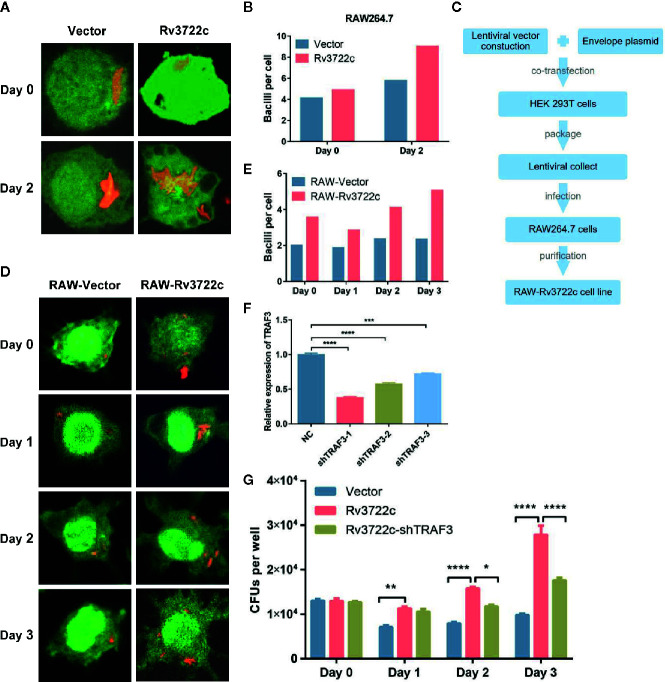
Knock-down of TRAF3 attenuates the effect of Rv3722c on M.tb proliferation. (A) pcDNA3.1-V5-Rv3722c or pcDNA3.1-V5 vector control and pAAV-eGFP were transiently co-transfected into RAW264.7 cells. Cells were infected with RFP-H37Ra at an MOI of 10 after transfected for 6 h. Cells were harvested for confocal microscopy-based image analysis at the indicated times. (B) Quantification of the average number of intracellular bacilli per cell in a total of 100 cells. (C) Flowchart of RAW-Rv3722c cell line construction. (D) RAW-Vector and RAW-Rv3722c cell lines were infected with RFP-H37Ra at an MOI of 10. Cells were harvested for confocal fluorescence microscopy-based image analysis at the indicated times. (E) Quantification of the average number of intracellular bacilli per cell in a total of 100 cells. (F) Identification of the mRNA expression of endogenous TRFA3 by qRT-PCR. (G) After infection of RAW-Rv3722c cells with lentivirus containing shTRAF3-1 gene for 48 h, the cells were infected with H37Ra at an MOI of 10. Cells were lysed and the CFUs of intracellular M.tb were detected by plating on 7H11 plates at the indicated times. Data shown in (F, G) are mean ± SD of three independent experiments. *P < 0.05; **P < 0.01; ***P < 0.001; ****P < 0.0001; ns, not significant; by two-way ANOVA or student t-test. All experiments were performed in triplicate.